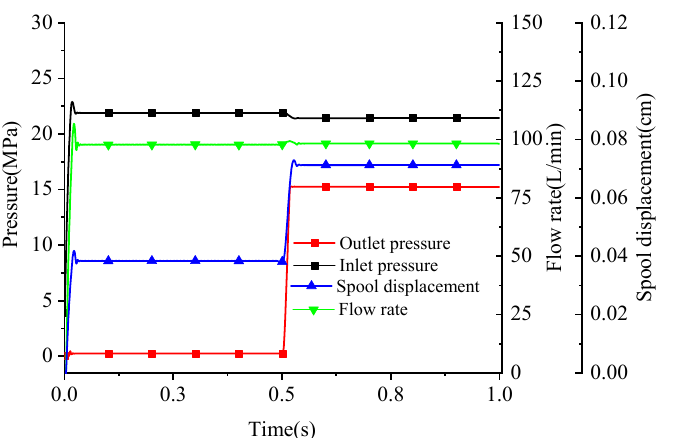
Figure 19. Pressure, flow rate and main spool displacement curves of relief valve under traditional working mode and with energy regeneration.